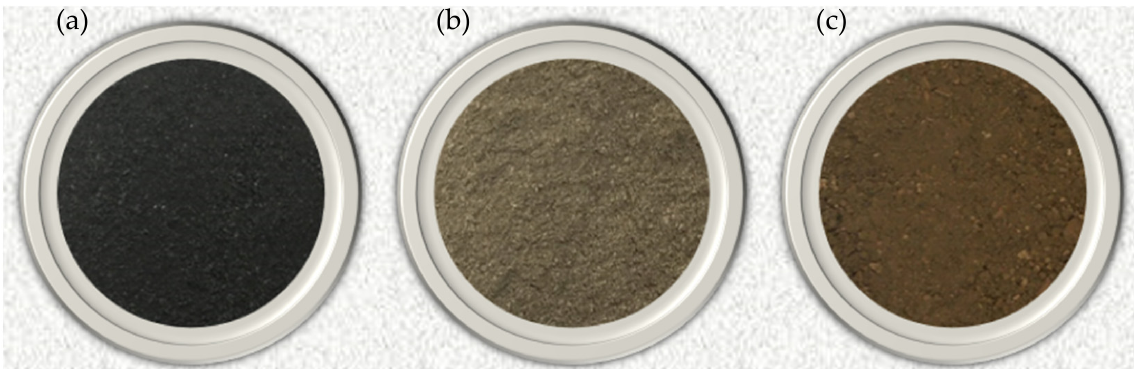
Figure 2. Photographic Views of ( a ) Lignin 1; ( b ) Lignin 2; and ( c ) Lignin 3.